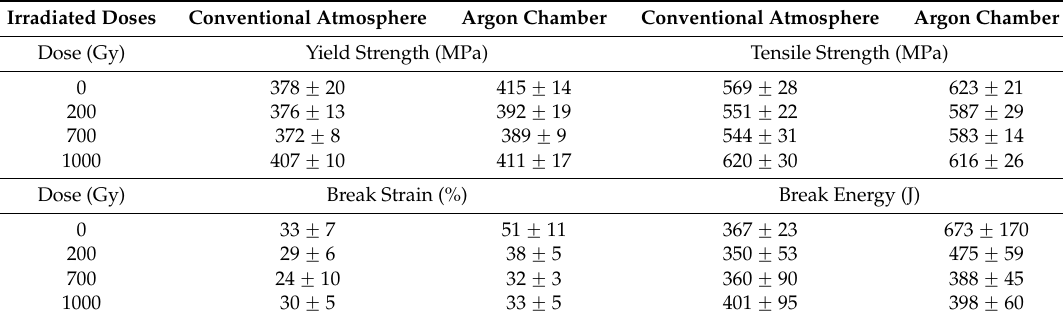
Table 2. Tensile Properties for radiation doses and types of welds.